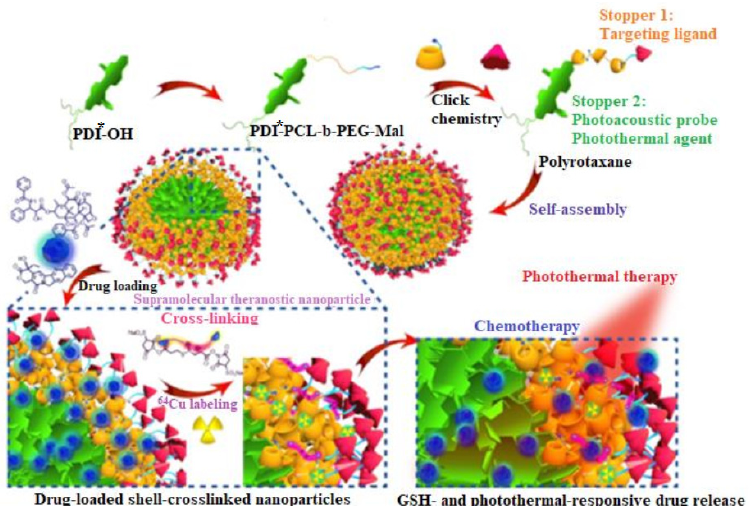
Figure 2. Diagram describes the production process of drug-loaded single-chain polymer nanopar- ticles (SCNPs) for dual-responsive drug release [38]. The abbreviations are PDI*: perylenediimide, PCL: polycaprolactone, PEG: polyethyleneglycol, and GSH: